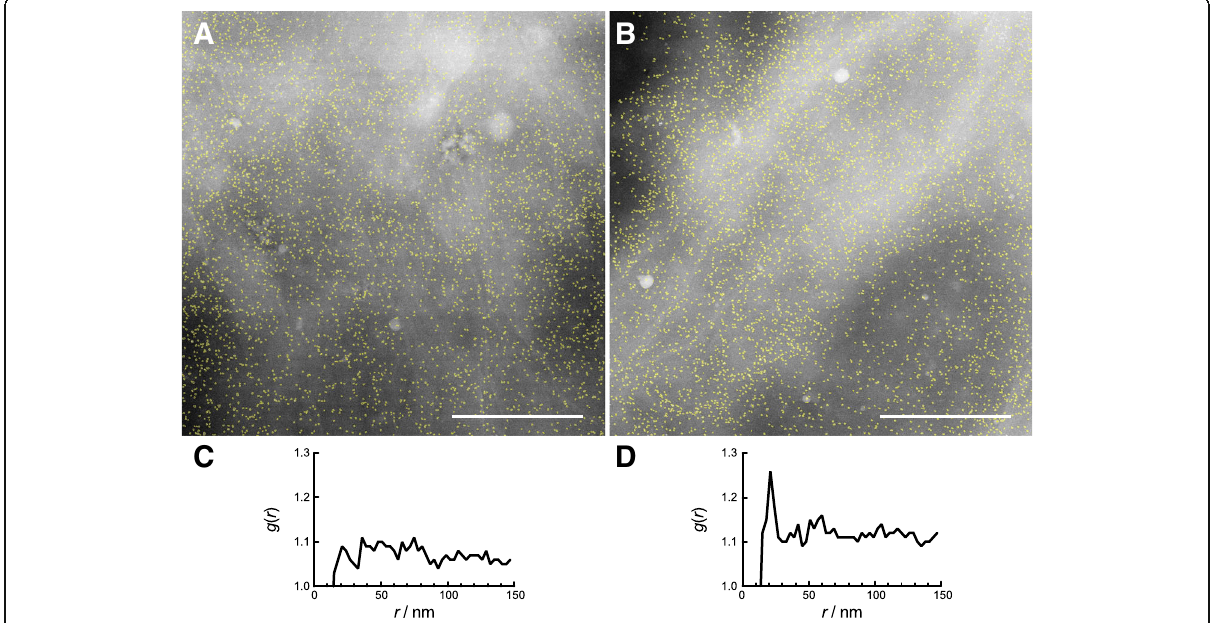
Fig. 5 High magnification STEM images (80,000 x) from neighbouring regions on the same cell differing in their content of HER2 homodimers. a The image shows a total of 4362 detected particles with a density of 823 particles/ μ m 2 . b A similar image, recorded only a few microns away from the first image, and with a similar number of labels and label density value (3567 detected particles and 680 particles/ μ m 2 ). c The g ( r ) analysis corresponding to A has no peak and thus indicates a lack of HER2 homodimers in this membrane region. d The g ( r ) for image b reveals a 20-nm peak indicating the presence of HER2 homodimers. Scale bars in a and b : 500